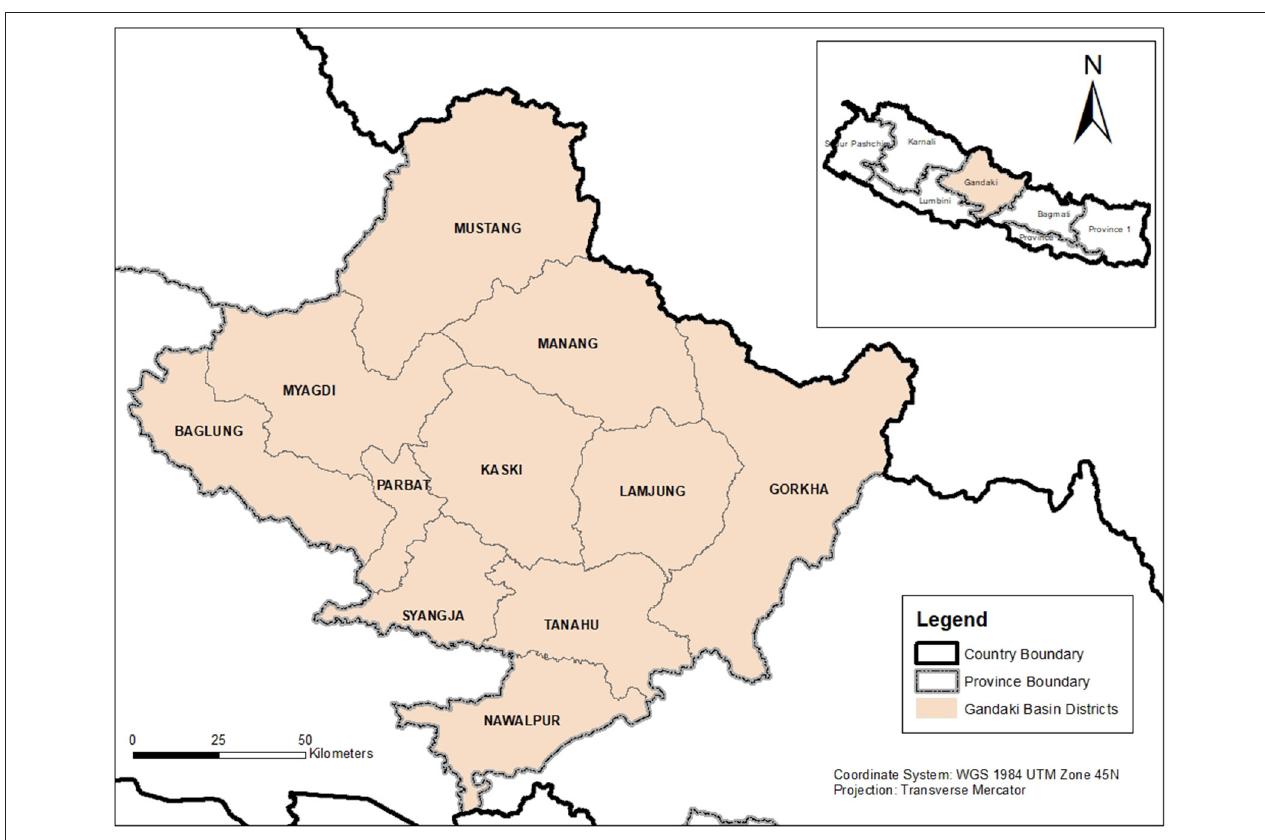
FIGURE 2 | Map of Nepal showing Gandaki